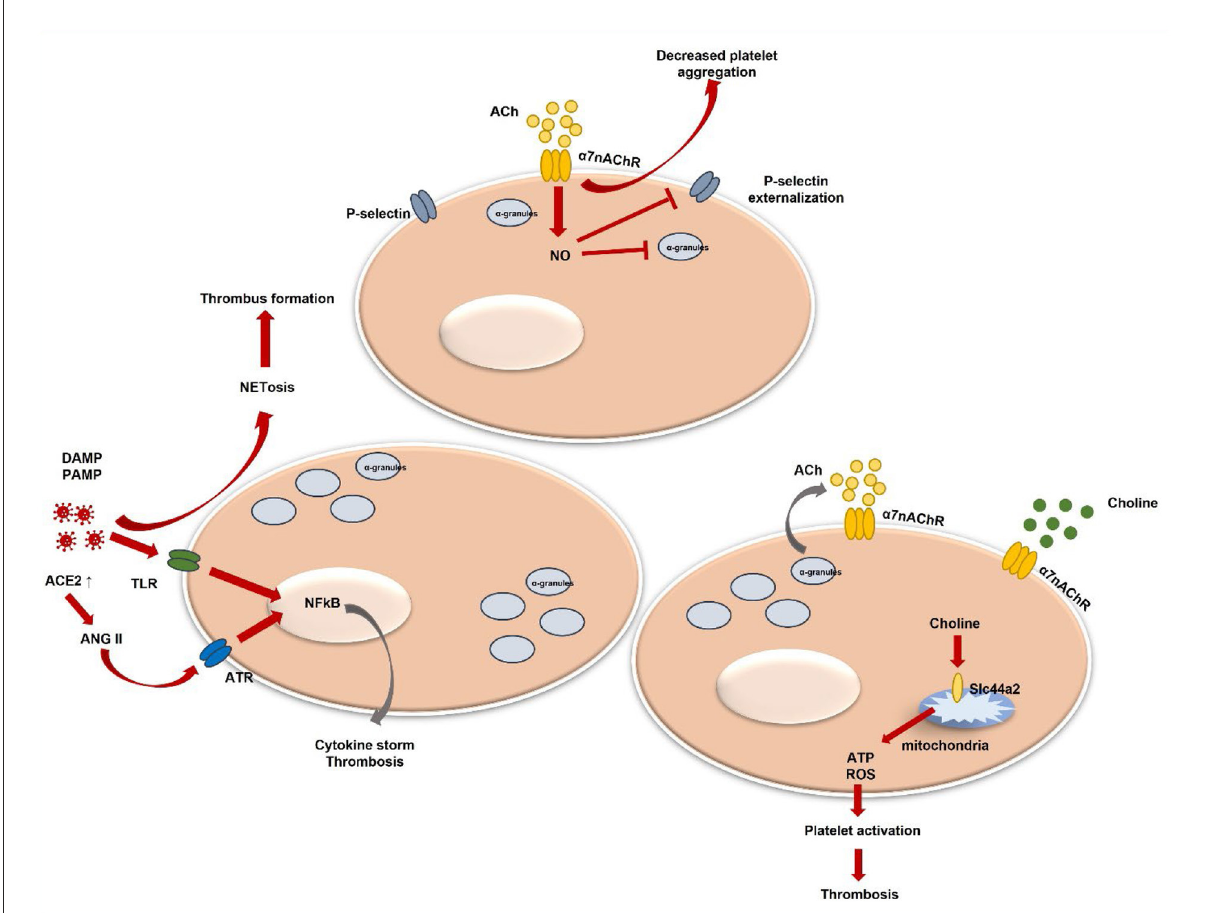
FIGURE1 Platelet activation and α 7nAChR involvement in thrombosis regulation. DAMPs, danger associated molecular patterns; PAMPs, pathogen associated molecular patterns; TLR, toll-like receptor; NF-kB, nuclear factor kappa-light-chain-enhancer of activated B cells; ACh, acetylcholine; NETosis, neutrophil extracellular trap formation; NO, nitric oxide; ACE2, angiotensin-converting enzyme-2; ANG II, angiotensin II; ATR, ANG II receptor; ATP, adenosine triphosphate; ROS, reactive oxygen species; α 7nAChR, alpha7 nicotinic acetylcholine